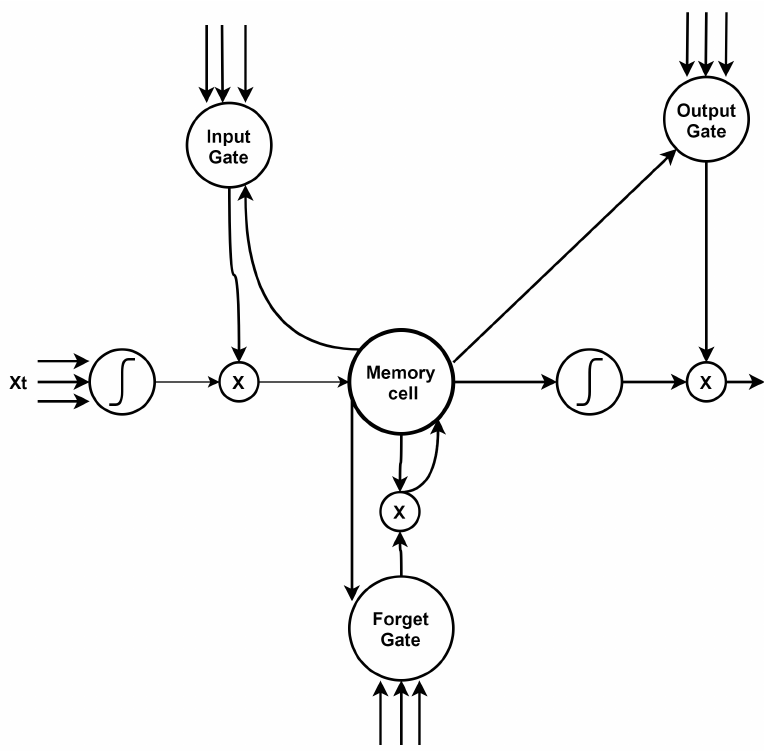
Figure 4. LSTM architecture with memory